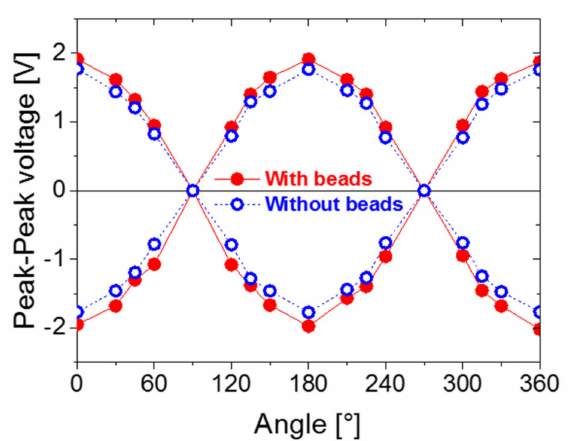
Figure 10. Experimental results of the relationship between the angle of the Wiegand sensor in the applied magnetic field and peak-to-peak voltage of the Wiegand pulse from the Wiegand